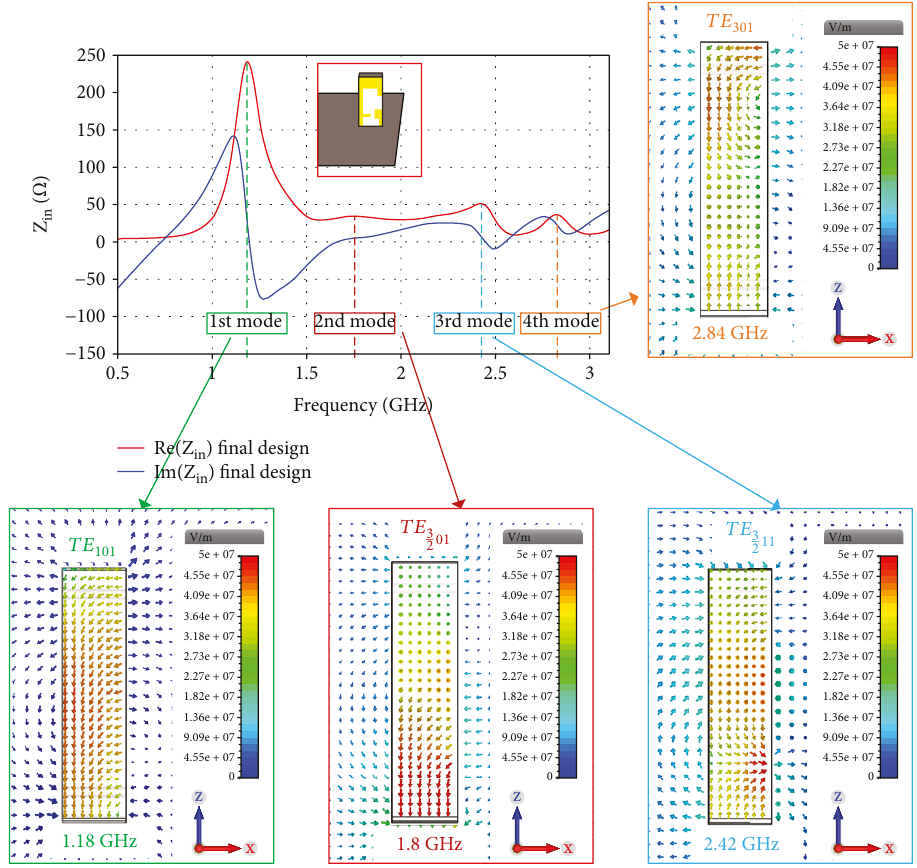
Figure 7: Input impedance with the modal analyses (E- fi elds) for the fi nal design.